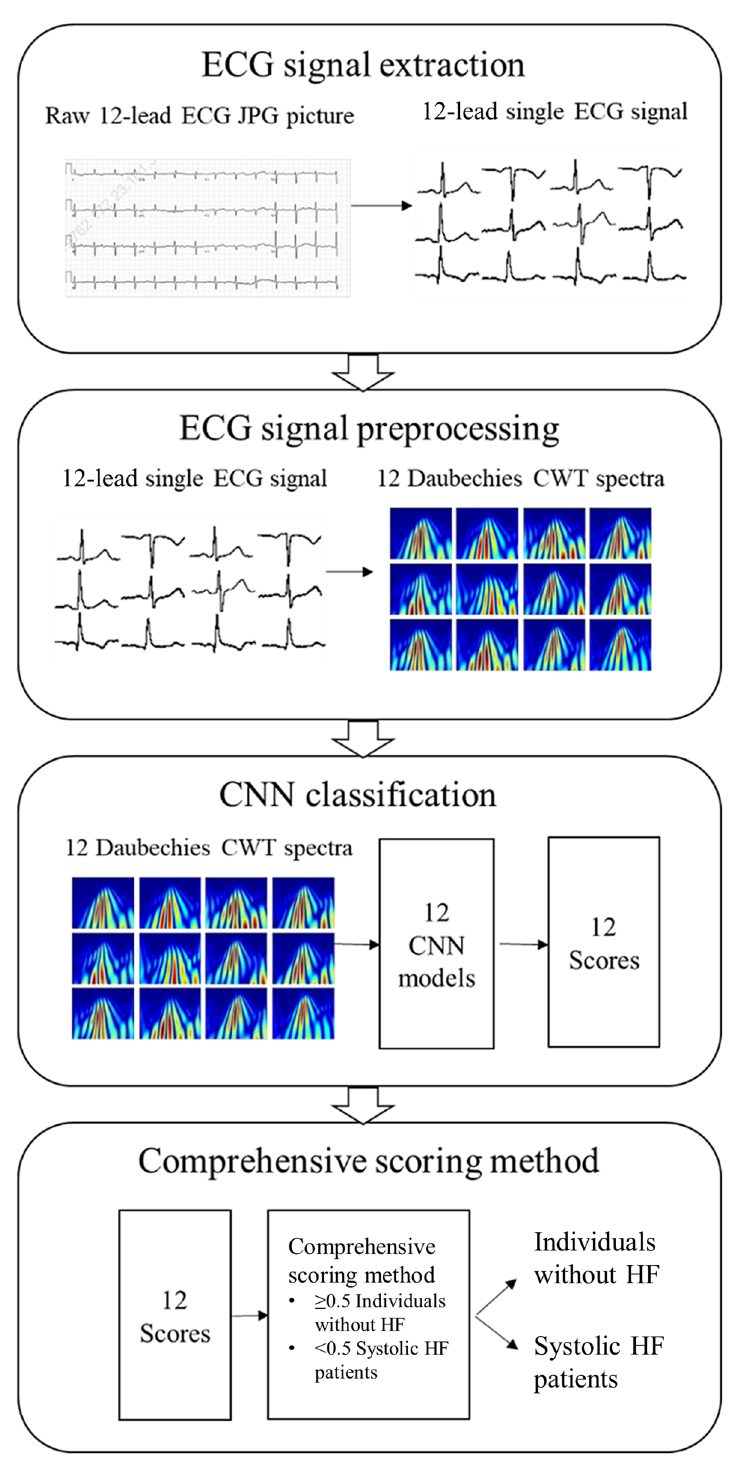
Figure 3. Illustration of the research process employed in this study. The first step was to extract the ECG signal from the JPG images. The second step was to transform each single-lead ECG signal into CWT spectra. In the final step, the spectra were trained separately in 12 models for the 12-leads, and the softmax layer output scores (ranging from 0 to 1) were recorded and applied for the comprehensive scoring method. Four comprehensive scoring methods were considered, including one where equal weights were given to the 12-leads and the key leads close to the left ventricle (Leads I, V5, and